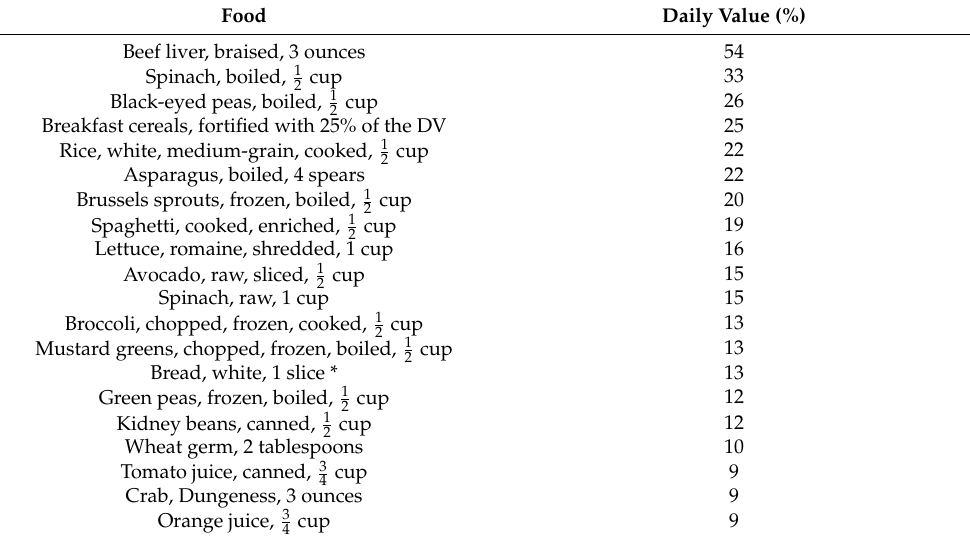
Table 1. Folic Acid Content in Foods [According to the National Institutes of Health, Food Supple- ments Administration